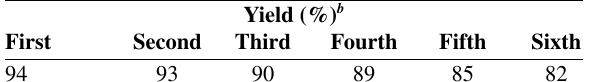
Table 4. Reusability of the Fe